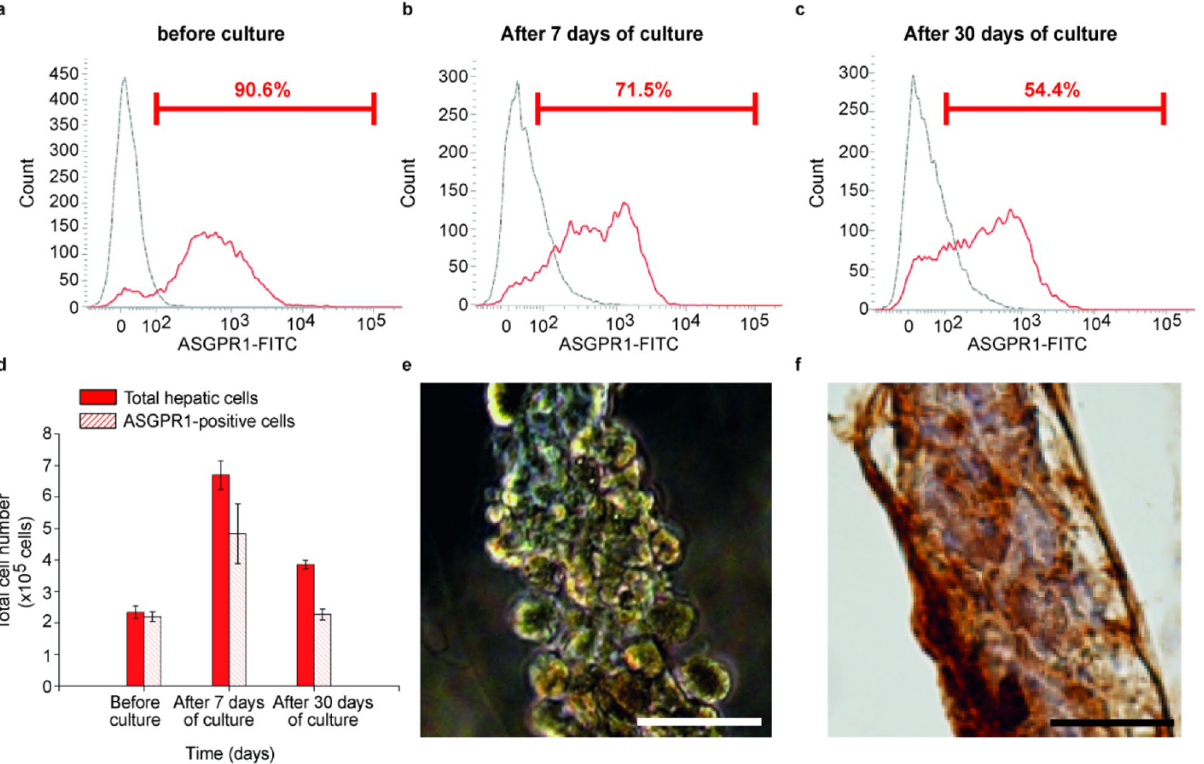
Figure 3. Hepatocyte detection in primary rat hepatic cells cultured in cell fibers using 3T3CM. ( a – c ) Representative FACS histograms (of 3 samples at least for each culture duration) showing the surface marker of asialoglycoprotein receptor-1 (ASGPR-1) on the primary rat hepatocytes ( a ) before culture, ( b ) after 7 days, ( c ) and 30 days of culture in cell fibers using 3T3CM. Red lines represent samples that were treated using both of a mouse-anti-human ASGPR1 antibody and a FITC-labelled goat anti-mouse antibody, while grey lines represent samples that were treated only with a FITC-labelled goat anti-mouse antibody. Red numbers in FACS histograms represent the percentage of cells that are positive for ASGPR-1. ( d ) Total cell number and ASGPR-1 positive cell number in primary rat hepatocytes before culture, after 7 days, and 30 days of culture (n = 3 at least per each time point). ( e ) Representative dark-field image (n = 3) and ( f ) representative image of immunohistochemical analysis for albumin localization (n = 3) of primary rat hepatocytes that were cultured for 7 days in cell fibers using 3T3CM. Scale bars; 50